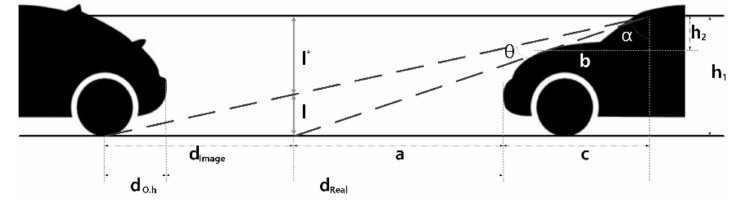
Figure 2. Principle of distance